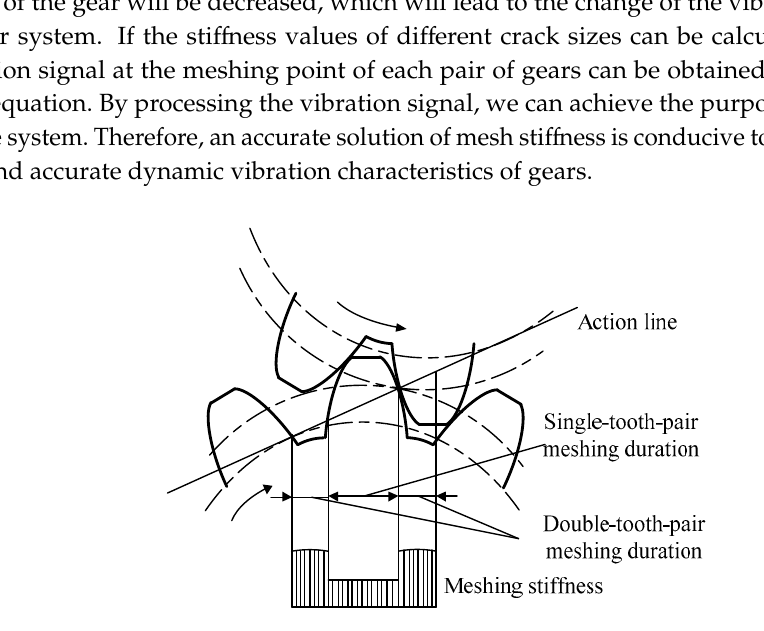
Figure 1. Schematic diagram of time-varying mesh stiffness (TVMS).